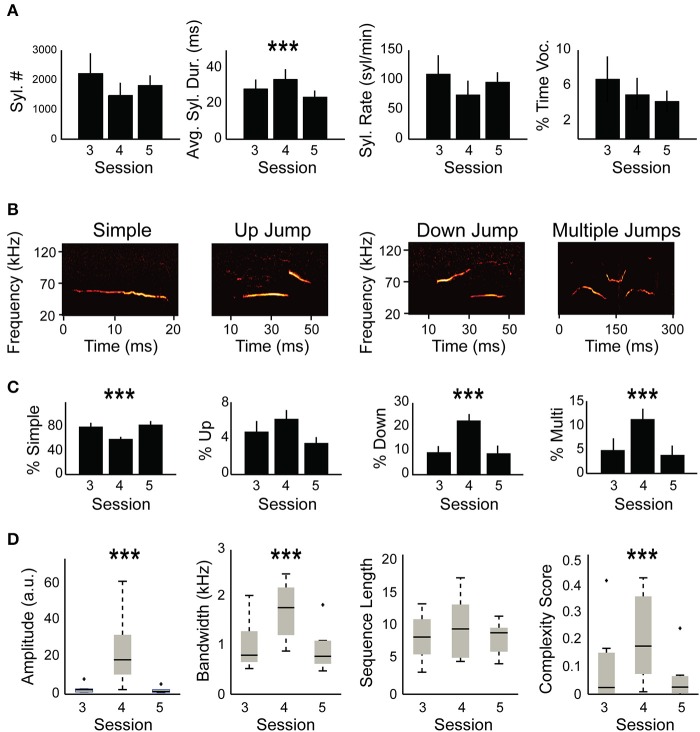
Syllable composition is different between non-restrained and head-restrained sessions. (A) Quantification of USVs including: total number of syllables, syllable duration, syllable rate, and fraction of time during USVs of the total session (in %). The averages of these parameters are compared between the head-fixed session (S4) and the session before (S3) and the session after (S5). Only average syllable duration was longer due to head restraint (p = 0.0005). (B) Spectrogram example from each syllable category including “simple,” “down,” “up,” and “multiple.” (C) Distribution of syllable types between the different sessions. A decrease in “simple” syllables in the head-restrained session (S4, p < 0.0001) is accompanied by an increase in “down jump” and “multiple jump” syllables (p < 0.0001) and “multiple jumps” syllables (p = 0.0003) while no change occurred in “up jump” syllables (p = 0.058). (D) Amplitude (p < 0.0001), bandwidth (p < 0.0001) and complexity (p = 0.0005) were affected by head restraint whereas sequence length (p = 0.12) did not show any significant differences. ***p < 0.001.